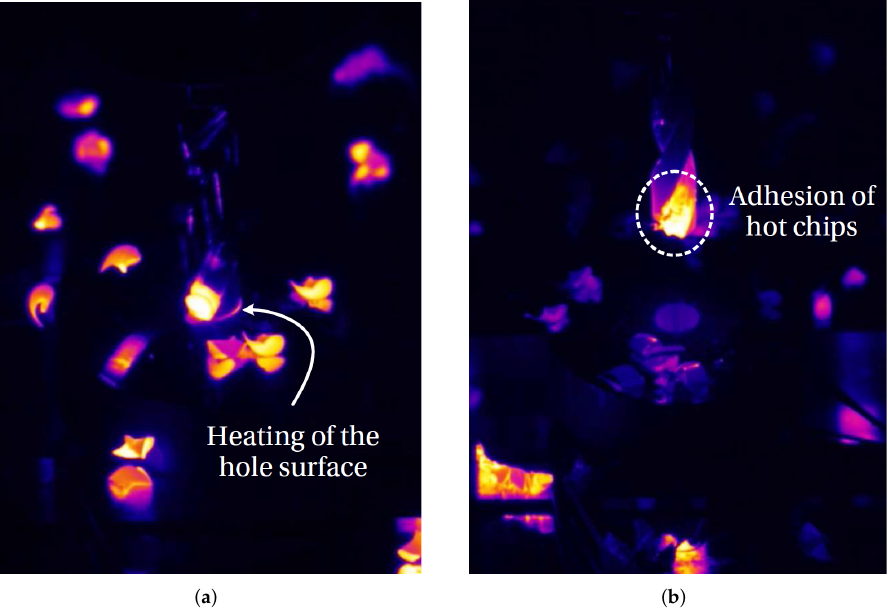
Figure 9. Pictures from the IR camera: ( a ) during the dry drilling; and ( b ) after the upward ejection of the